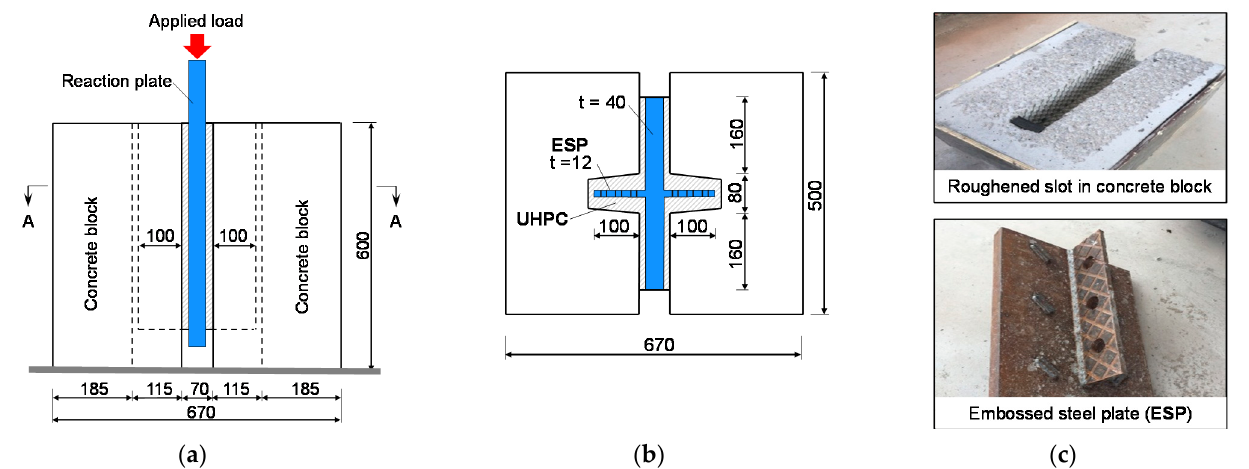
Figure 3. General details of push-out specimens (dimensions in mm): ( a ) elevation view; ( b ) plane view; ( c ) roughness treatment.